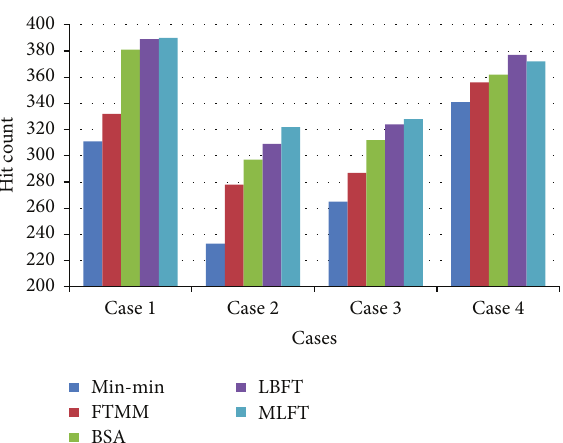
Figure 5: Performance based on hit count.